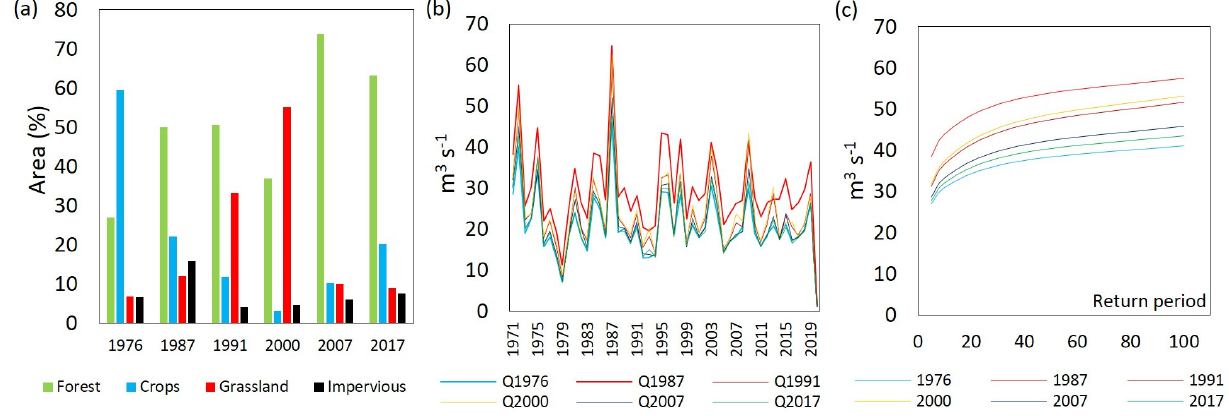
Figure 3. Hydrological response by land–use change period. ( a ) land–use areas, ( b ) annual maxima, and ( c ) flood quantiles. Table 2. Hydraulic characteristics of cross-sections per